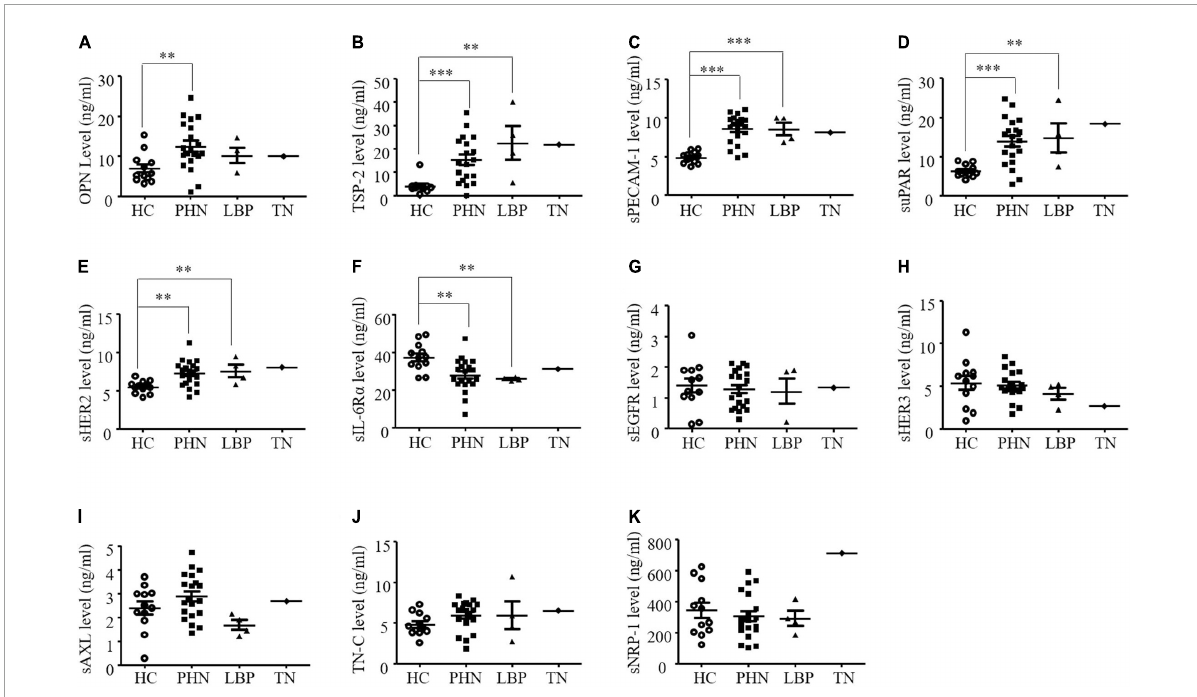
FIGURE2 (A-K) Comparison of serum angiogenic factors in healthy controls (HC) and patients with postherpetic neuralgia (PHN), low back pain (LBP), or trigeminal neuralgia (TN). ** P < 0.01; ∗∗∗ P < 0.001. OPN, osteopontin; TSP-2, thrombospondin-2; sPECAM-1, soluble platelet endothelial cell adhesion molecule-1; suPAR, soluble urokinase-type plasminogen activator receptor; sErbB2, soluble human epidermal growth factor receptor 2; sIL-6R α , soluble interleukin-6 receptor α ; sEGFR, soluble epidermal growth factor receptors; sErbB3, soluble human epidermal; sAXL, soluble AXL; TN-C, tenascin C; sNRP-1,